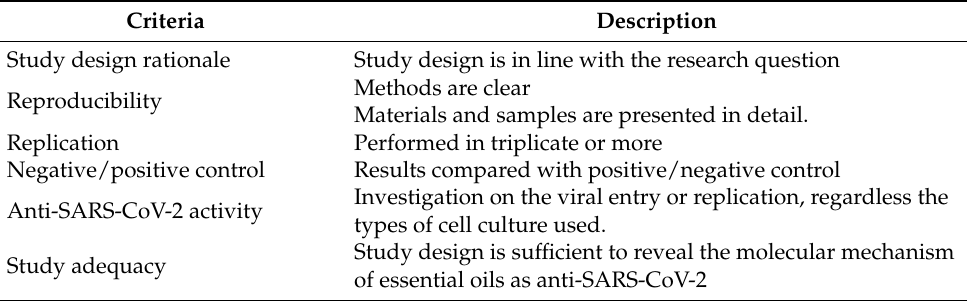
Table 1. Criteria used to appraise the quality of the included